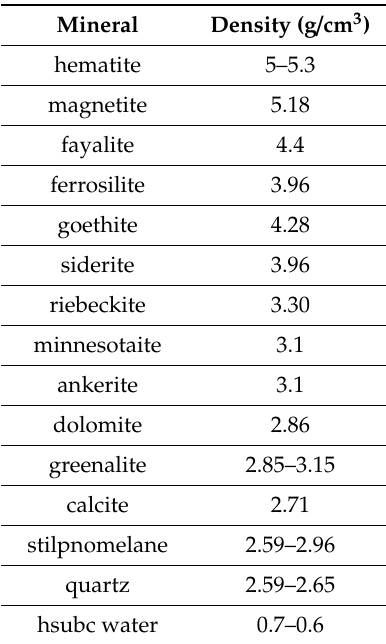
Table 2. Density (volumic mass or mass per unit volume) of minerals (values are those of the handbook of mineralogy) and of hsubc water educed from Figure 2 in